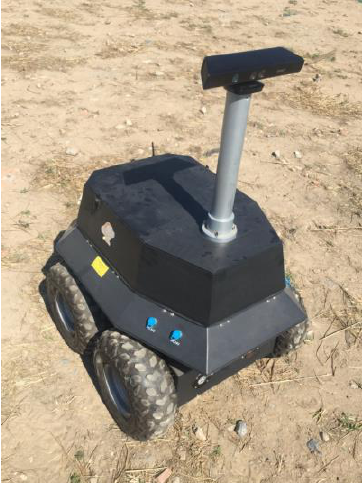
Figure 2. The RGB-D camera mounted on the moving platform Experiment was performed in an outdoor field to simulate the lunar surface. The rover travelled along a loop path with the origin set at [0,0]. The same image was used for the first and last positions to ensure that the true last camera pose was exactly the same as where the first image was recorded. Given that the loop is closed, we can use it to evaluate the accuracy. camera and the depth